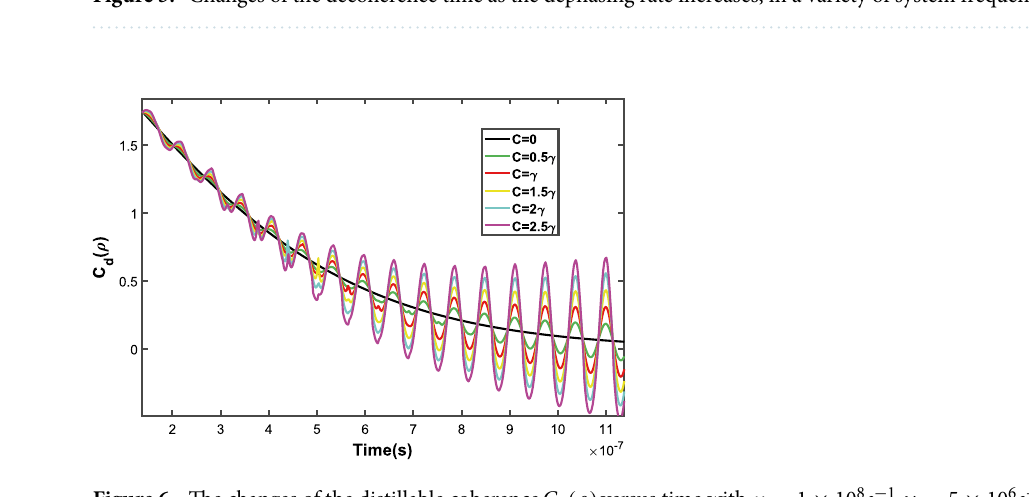
Figure 5. Changes of the decoherence time as the dephasing rate increases, in a variety of system frequencies.